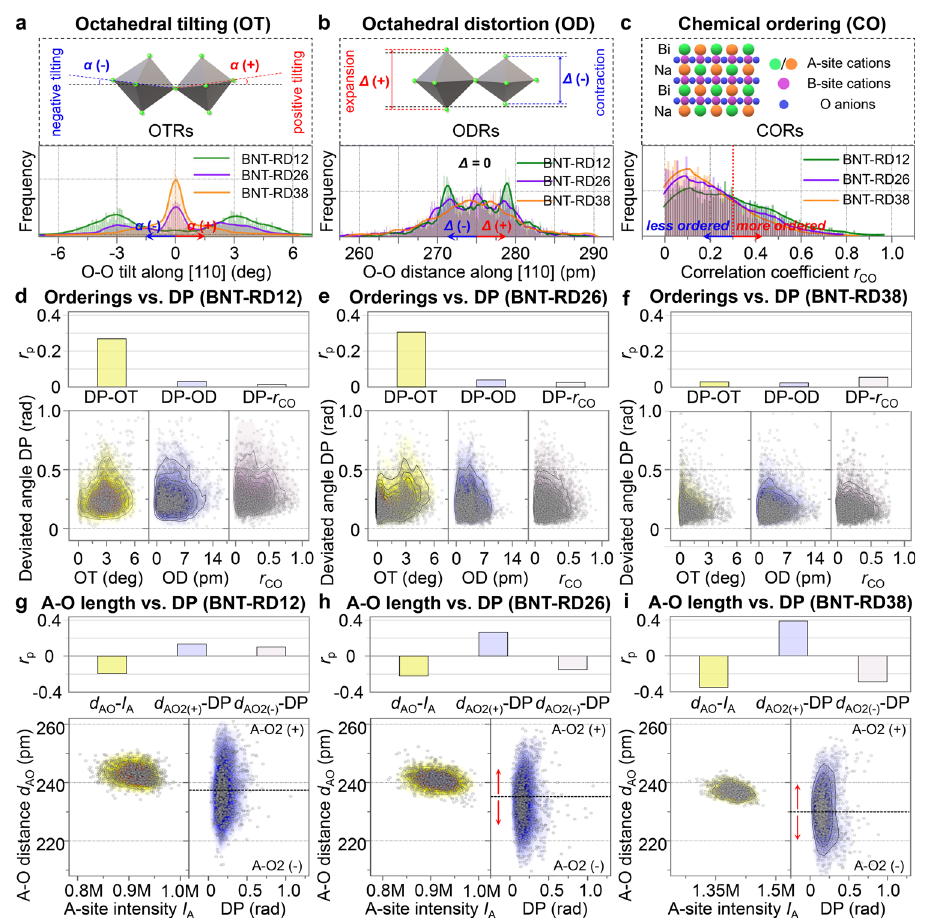
Fig. 3 | Correlation analysis between local orderings and the deviated polar- ization. a – c Schematic illustration (top), and statistical distribution (bottom) of local orderings in the BNT-based system, including a oxygen octahedral tilting (OT), b oxygenoctahedraldistortion(OD), c chemicalordering(CO). d – f Statistical point-to-point correlation analysis revealing the relationship between three local